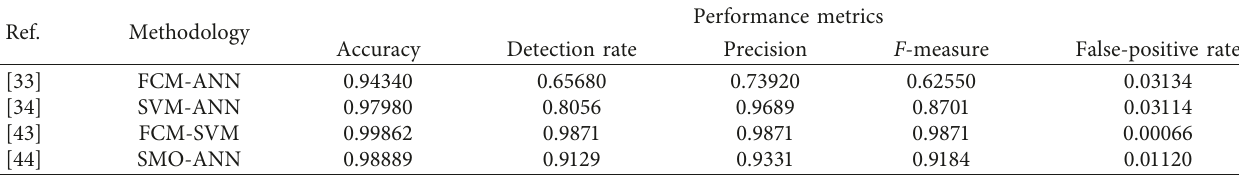
Table 13: Comparison of various methodologies based on different performance metrics for the UNSW-NB15 dataset. Ref.